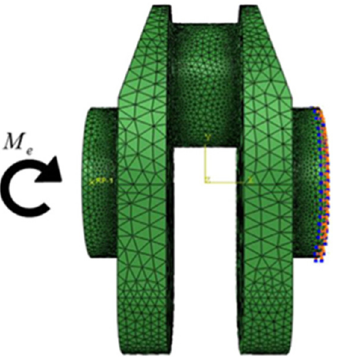
Figure 10. The finite element model for bending analysis.